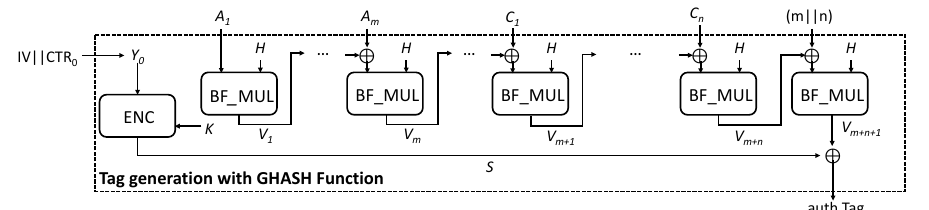
Figure 5. GHASH function process ( A 1 , . . . , A m are additional authenticated data (AAD) and C 1 , . . . , C n are blocks encrypted by CTR mode).